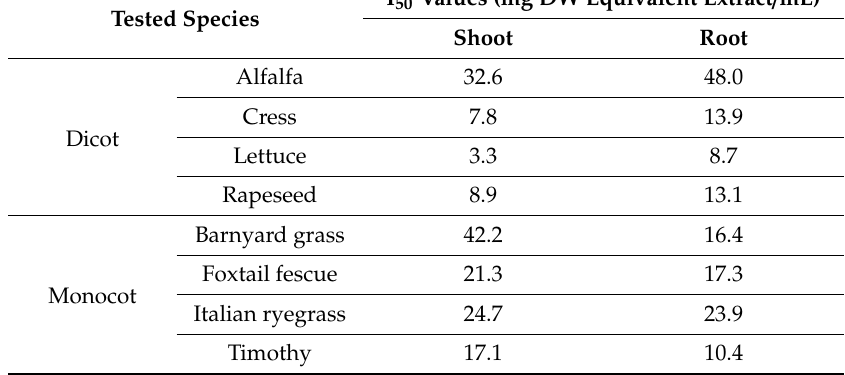
Table 1. The I 50 values of the aqueous methanol extracts of Wedelia chinensis against shoot and root growth of the tested species.